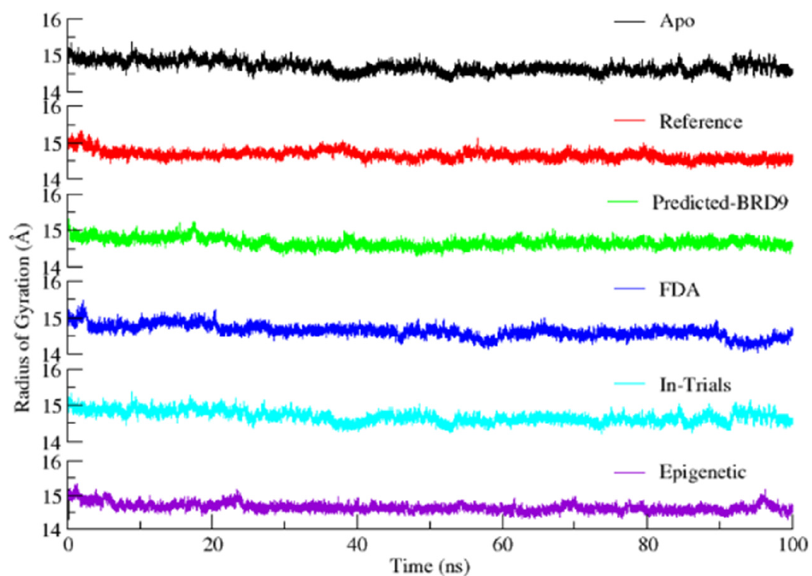
Figure 18. Radius of gyration plots of BRD9, Apo (black); Reference (red); ZINC433599781; ZINC28223750 (blue); ZINC2036848 (cyan); ZINC95589781 (purple).